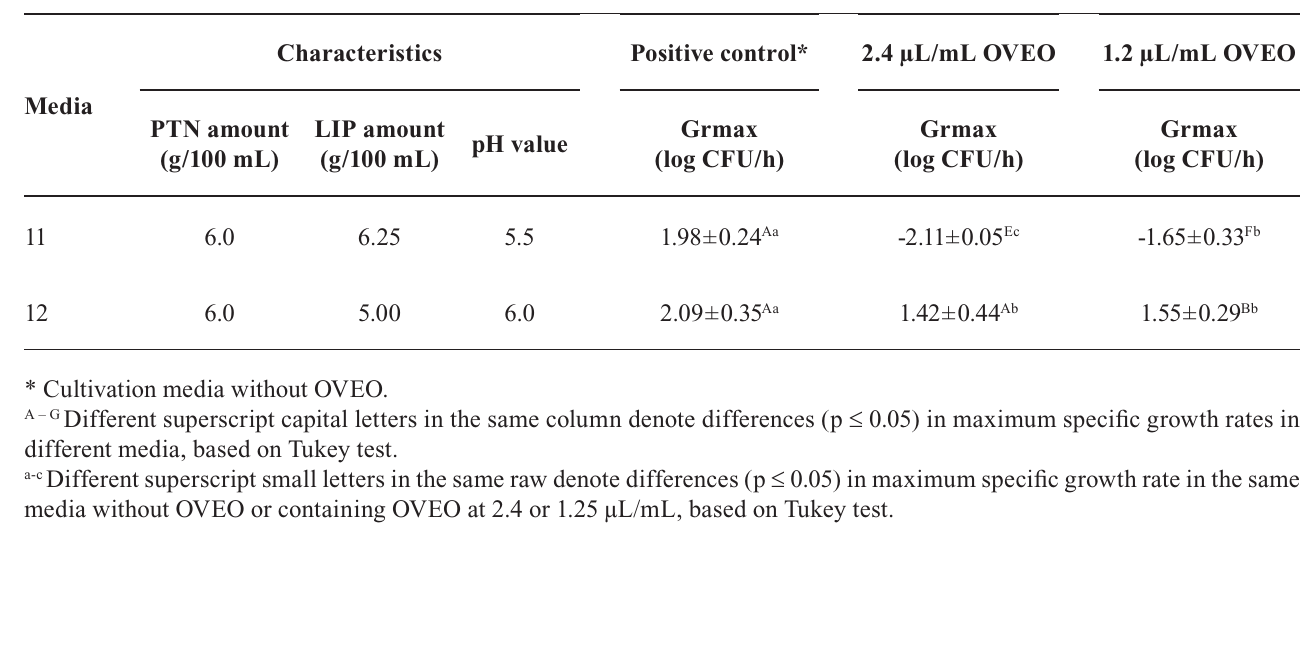
TABLE III - Maximum specific growth rate (Grmax, log CFU/h) estimates for Salmonella Typhimurium PT4 in media with different amounts of proteins, lipids and pH values and 2.4 or 1.2 µL/mL Origanum vulgare L. essential oil (OVEO). Results of Grmax values are expressed as the average ± standard deviation (n=9). The Grmax values were measured by EON-Gen5 software (EON, BioTek, USA) considering the results of absorbance based microtiter plate